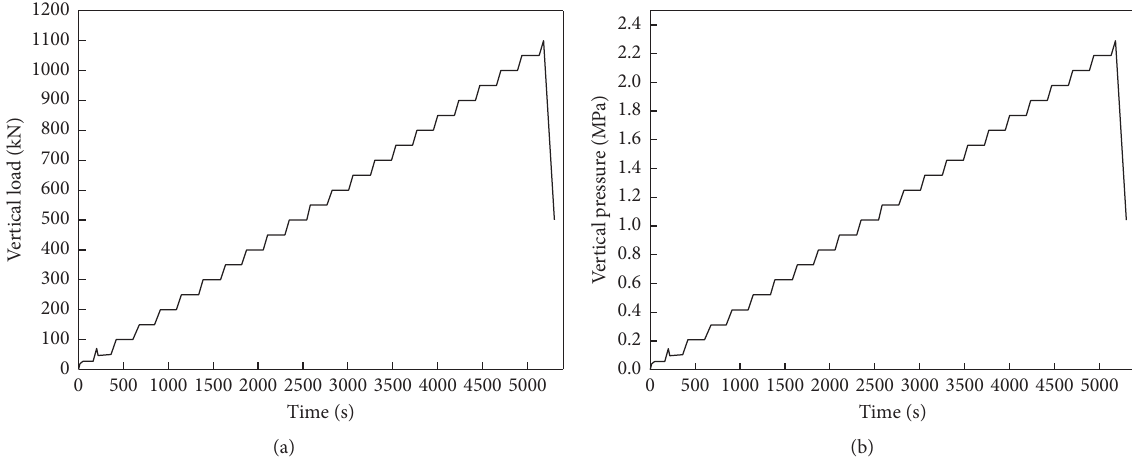
Figure 4: The loading curve. (a) The loading curve of the testing machine. (b) Converted to wall top pressure.